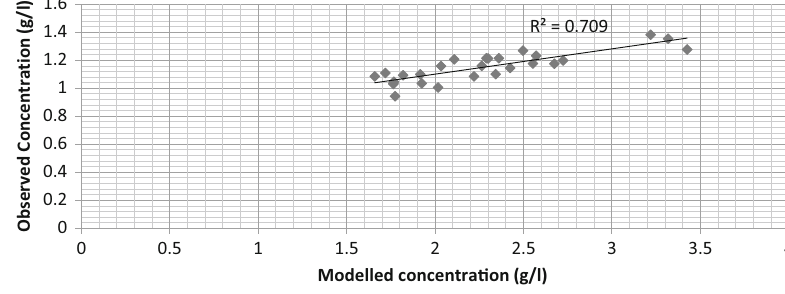
Fig. 6 The regression